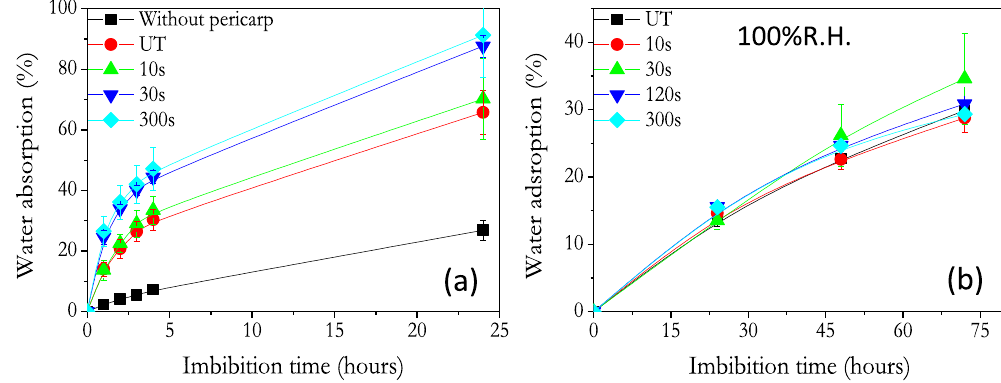
Figure 4. Weight increase of seeds due to water absorption (respect to the initial weigth) of nasturtium seeds imbiting at 21 °C. ( a ) Water uptake from water rich environment for plasma treated seeds as a function of time